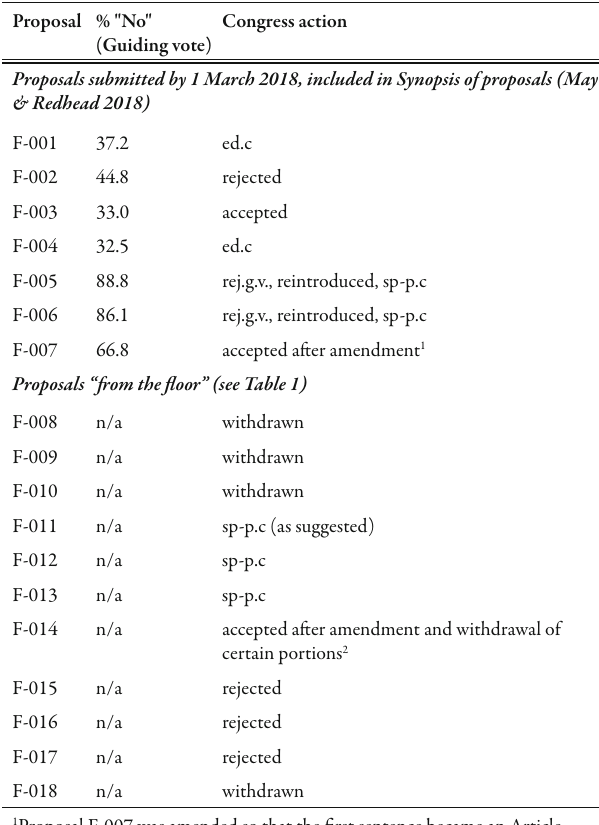
Table 2. Actions on nomenclature proposals considered by the Fungal Nomenclature Session of IMC11. Abbreviations : ed.c. = referred to the Editorial Committee; rej.g.v. = rejected on Guiding vote; sp-p.c. = referred to a Special-purpose